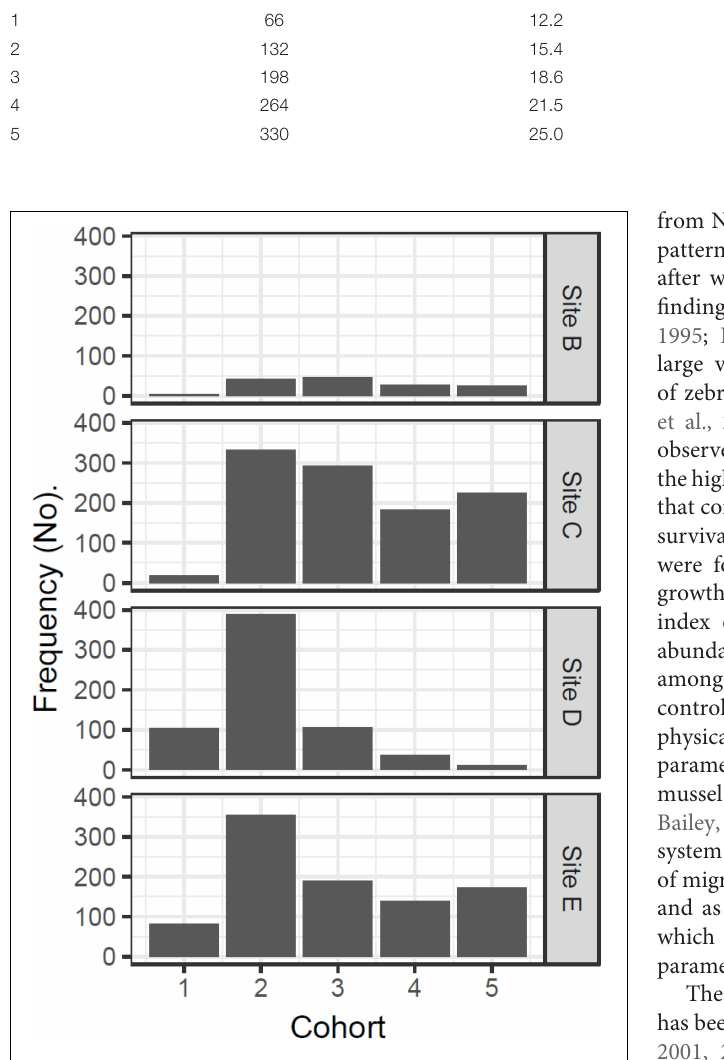
FIGURE 7 | Site variation in the relative frequency of different cohorts colonizing the experimental panels in Cardiff Bay derived from mixture